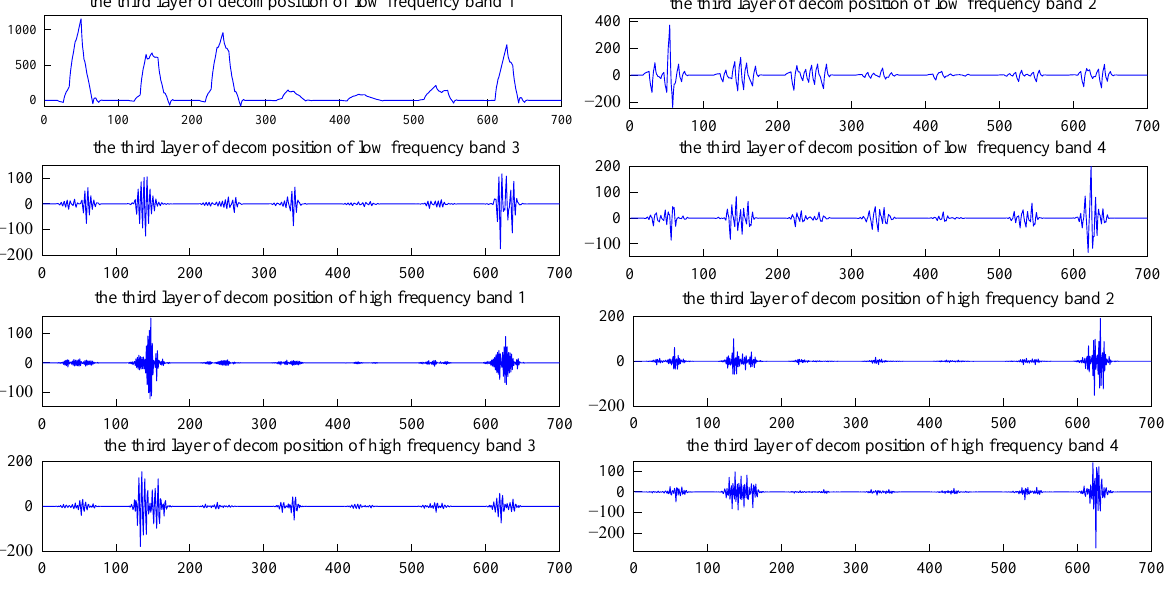
Figure 2. Results of WPD for the original series of wind speed.